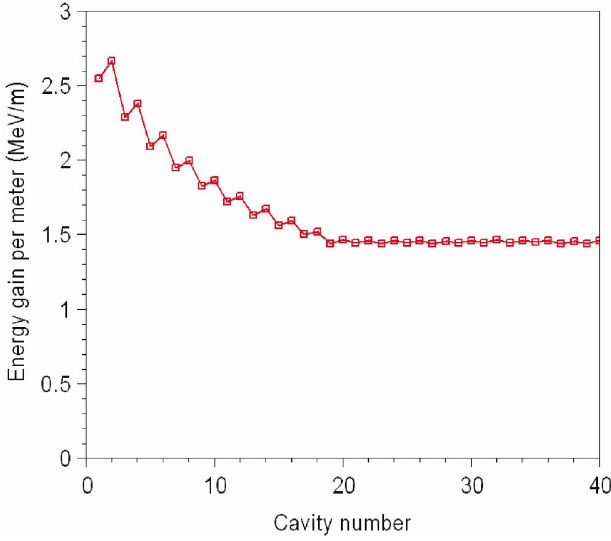
FIG. 19. (Color) Energy gain vs cavity number.